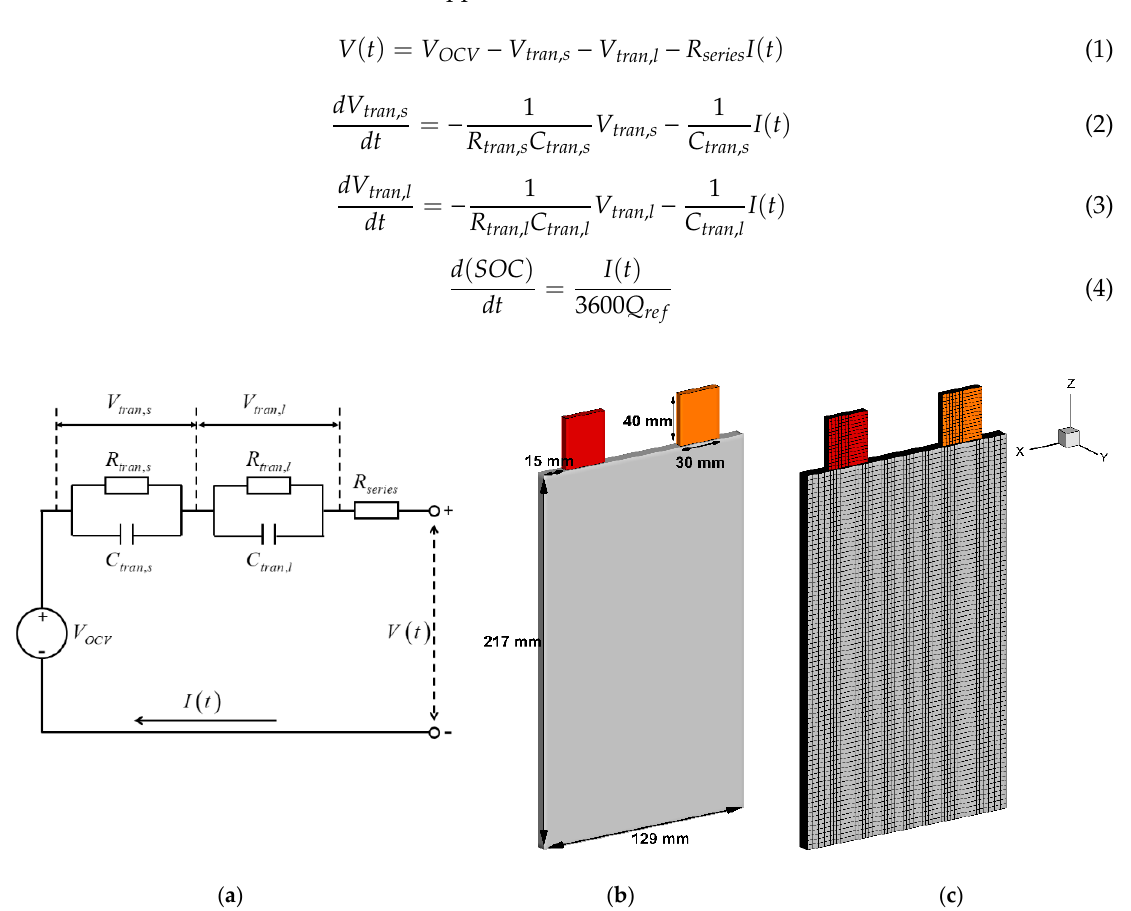
Figure 1. Schematic of ( a ) equivalent electrical circuit; ( b ) geometry; ( c ) mesh of multi-scale multi-domain Figure1. Schematicof( a )equivalentelectricalcircuit; ( b )geometry; ( c )meshofmulti-scalemulti-domain lithium-ion battery thermal modeling. lithium-ion battery thermal